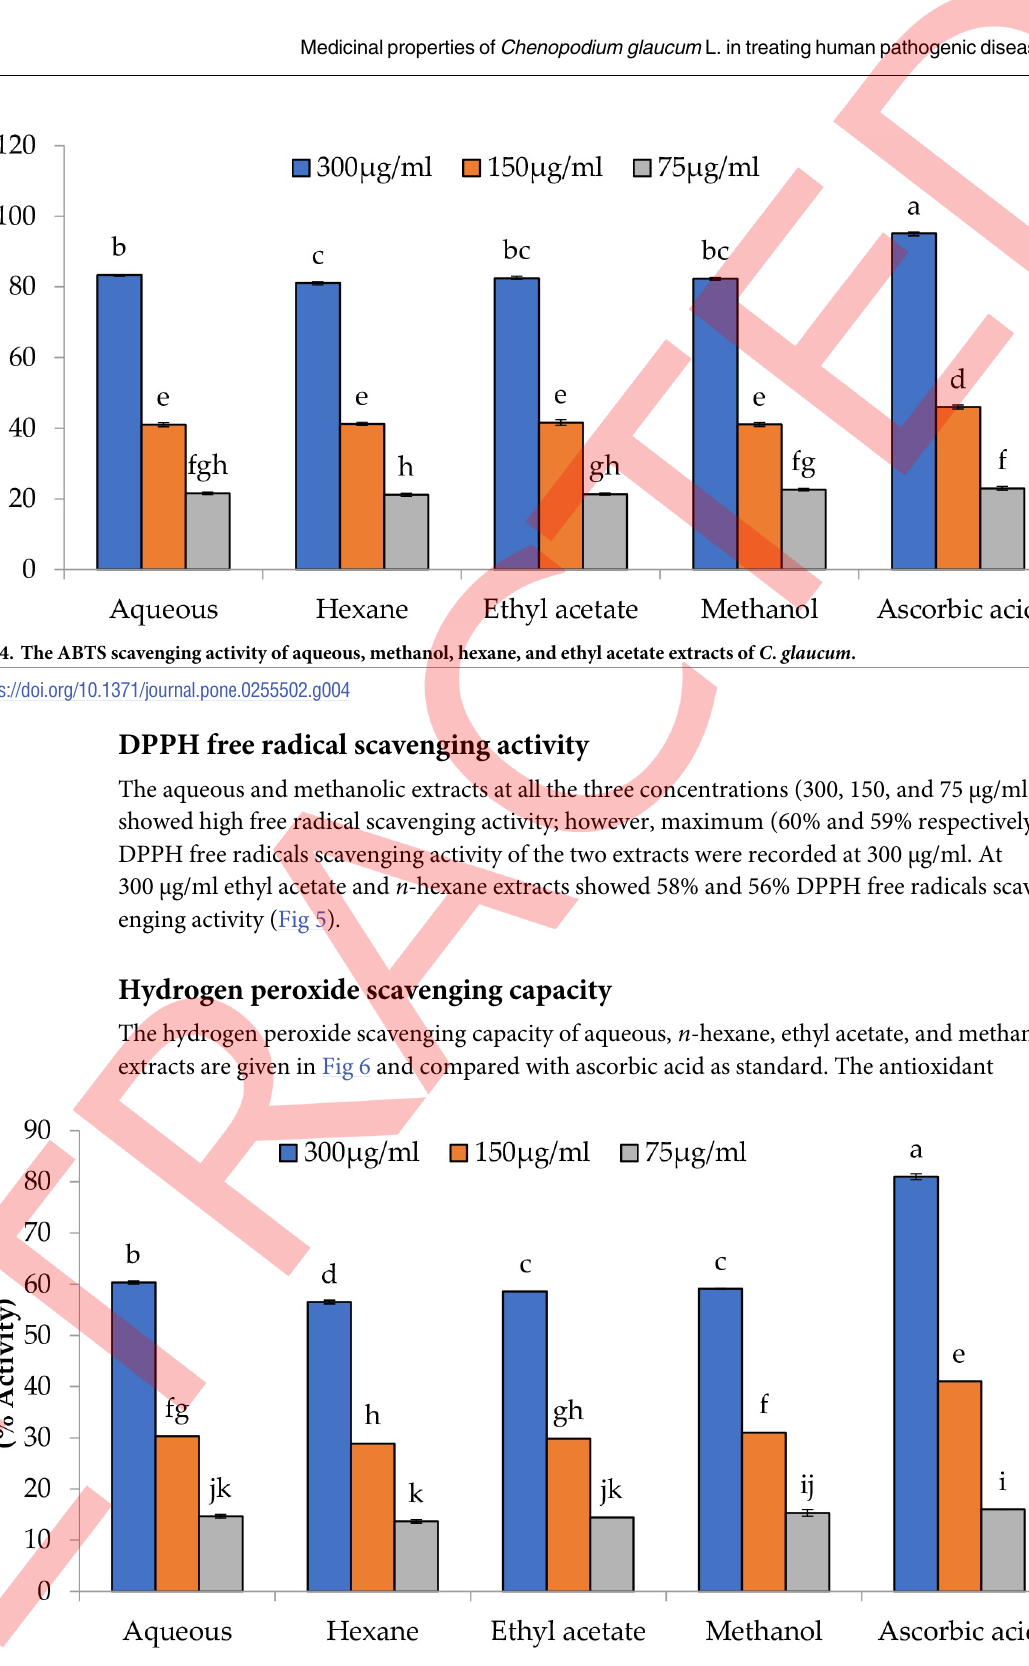
Fig 5. The DPPH scavenging activity of aqueous, methanol, hexane and ethyl acetate extracts of C . glaucum .